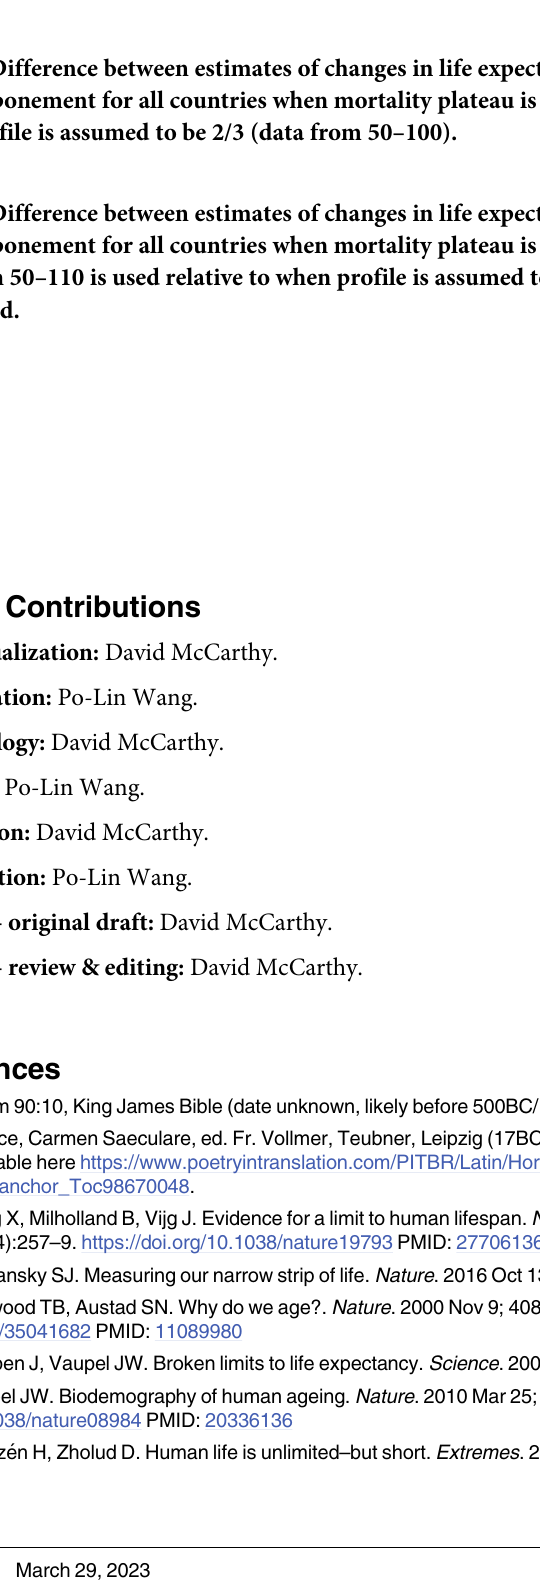
S12 Fig. Difference between estimates of changes in life expectancy due to compression and postponement for all countries when data from 50–110 is used relative to when data from 50–100 is used. (TIF) S13 Fig. Difference between estimates of changes in life expectancy due to compression and postponement for all countries when mortality plateau is assumed to be 1 relative to when profile is assumed to be 2/3 (data from 50–100). (TIF) S14 Fig. Difference between estimates of changes in life expectancy due to compression and postponement for all countries when mortality plateau is assumed to be 1 and when data from 50–110 is used relative to when profile is assumed to be 2/3 and data from 50– 100 is